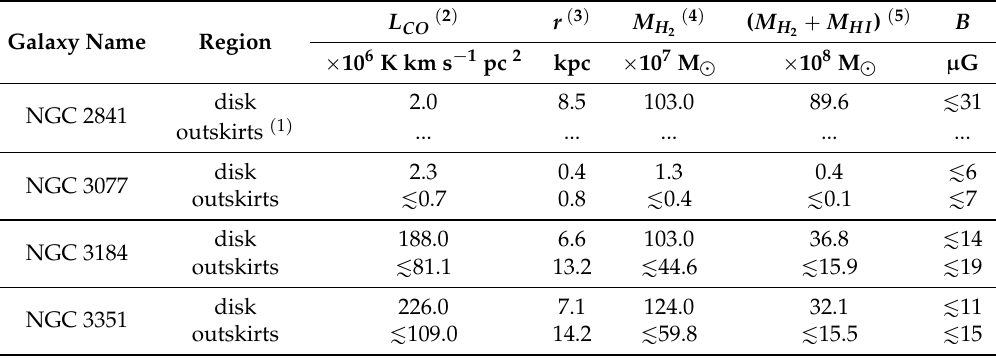
Table 3. Parameters derived for the galaxy